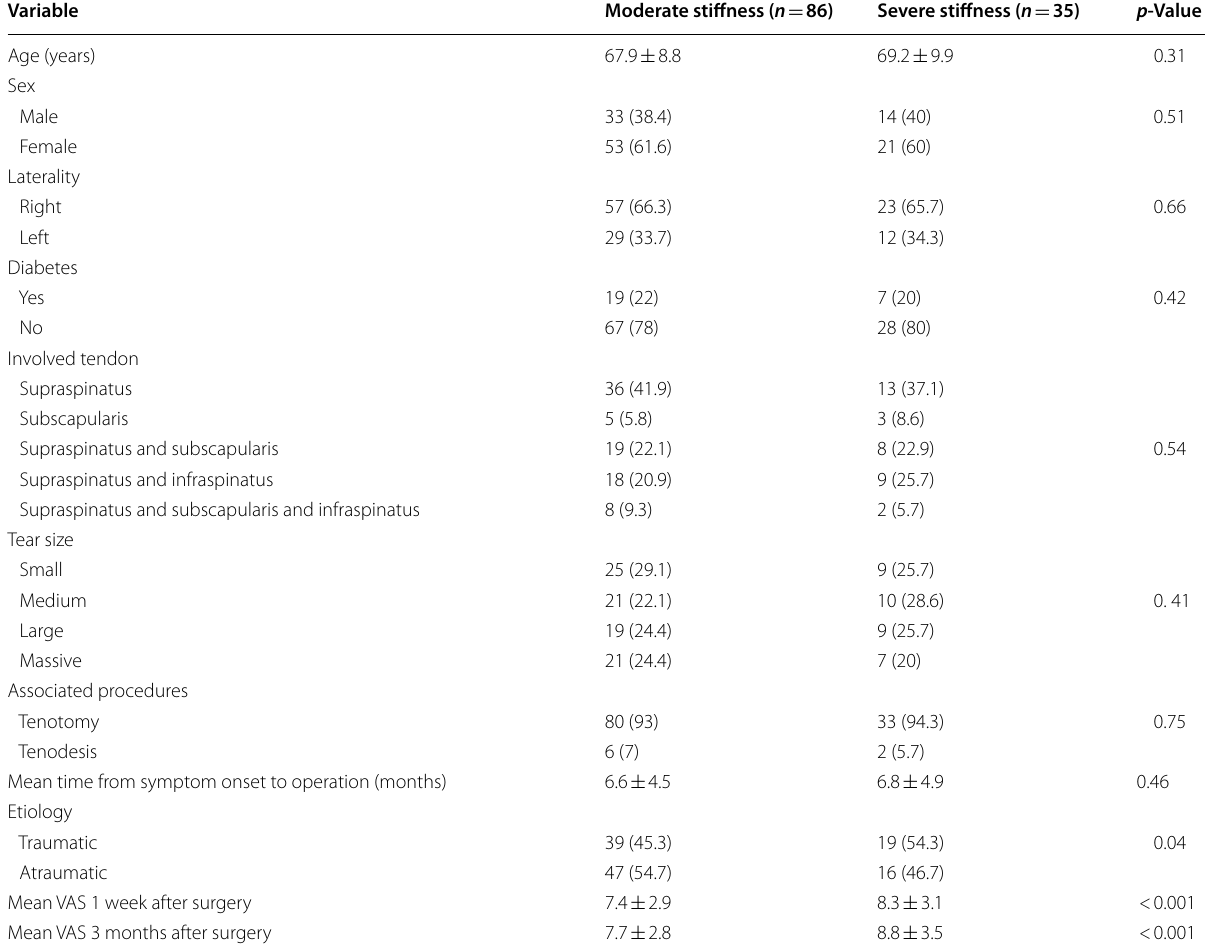
Data are shown as mean VAS visual analog